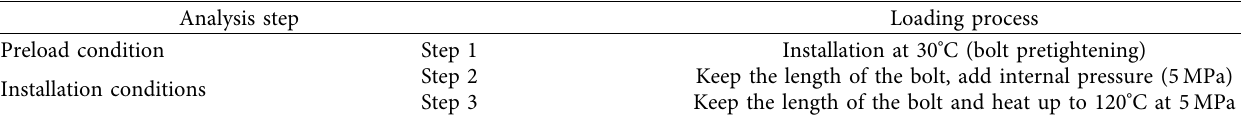
Table 3: The step